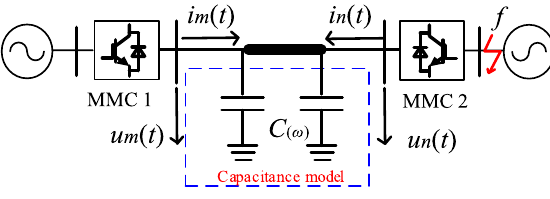
Fig. 2 Traditional model identification